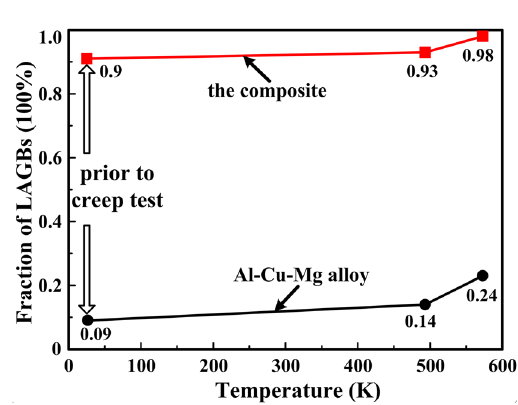
nano-sized TiC x particles affect the microstructure of the present composite. It can be observed that nano-sized TiC x particles distribute in both grain interiors and at grain boundaries (Fig. 1d), which can be depicted in model (I) and (II). In model (I), according to Orowan strengthening mechanism, a portion of dislocations mobility can be hindered by nano-sized TiC x particles, resulting in the dislocations pile-up in the grain interior. The col- lective dislocations’ motion arrays that makes up LAGBs. Moreover, the other part of dislocations slip or climb through the nano-sized TiC x and finally vanishes at grain boundaries. In model (II), nano-sized TiC x are located at HAGBs and LAGBs. During the creep test, HAGBs will translate to LAGBs on account of grain rotation, which is semblable to the model mentioned in Fig. 8a. But the difference is that the translated LAGBs will be pinned by nano-sized TiC x through Zener pinning 34 . Zener pinning plays a major role at boundaries, when the ratio for volume fraction of particle to its diameter (Fv/d) in alloys is larger than 100 nm − 1 . In addition, the already existed LAGBs will also be pinned. It might explain partially why the fraction of LAGBs in the composite increases after creep deformation (Fig. 6e and f). Figure 9 shows TEM images of Al-Cu-Mg alloy and the composite having 9 vol.% nano-sized TiC x after the creep test at 493 K, 533 K and 573 K under a stress of 60 MPa. All the pictures are taken along [001] Al direc- tion of α -Al. Apparently, the average sizes of θ ′ and S ′ precipitates in both Al-Cu-Mg alloy and the composite increase with the increase in temperature. After the creep test at 493 K, θ ′ precipitates in Al-Cu-Mg alloy have an average size of about 250 nm, while the mean size of that in nano-sized TiC x /Al-Cu-Mg composite is merely about 100 nm, as shown in Fig. 9a and b. Moreover, the size of S ′ precipitates is found to be inhomogeneous. At temperatures in the range of 533K-573K, the average size of θ ′ precipitates in Al-Cu-Mg alloy grows from about